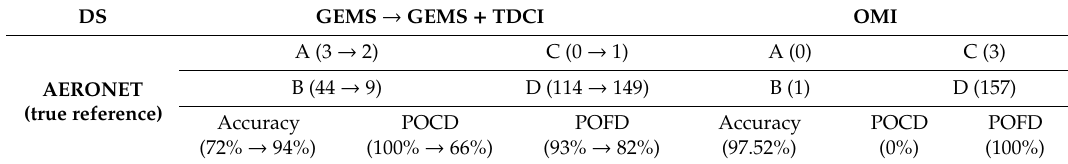
Table 3. Calculated accuracy, POCD, and POFD for DS detected GEMS aerosol type.